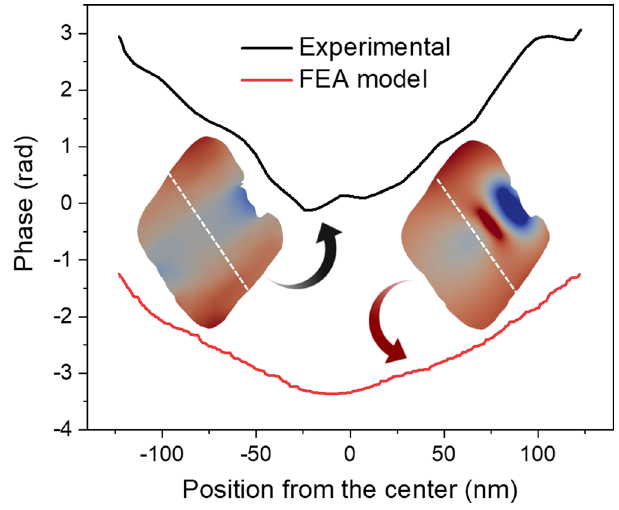
Fig. 3 Phase line plot for the experimental data and the FEA model. The insets are cross-sectional views of the experimental (middle-left) and FEA model (middle-right). The white dashed lines represent the position of the phase line plot for the experimental result (solid black line) and FEA model (solid red